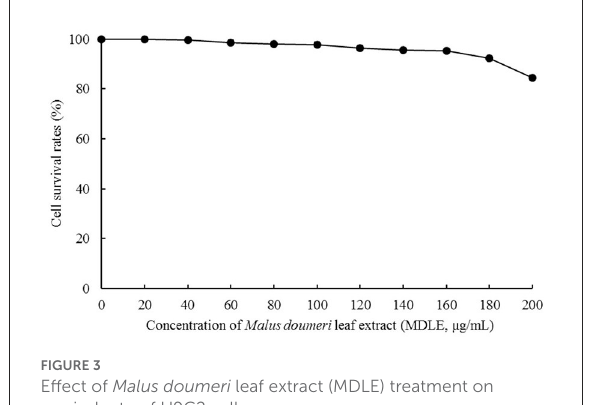
FIGURE3 Effect of Malus doumeri leaf extract (MDLE) treatment on survival rate of H9C2 cells.